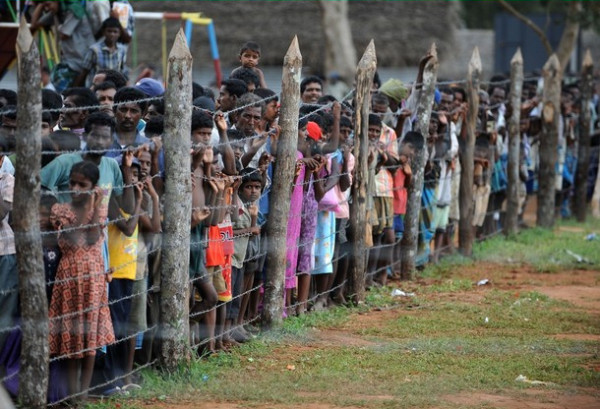
Internment Camps [111].